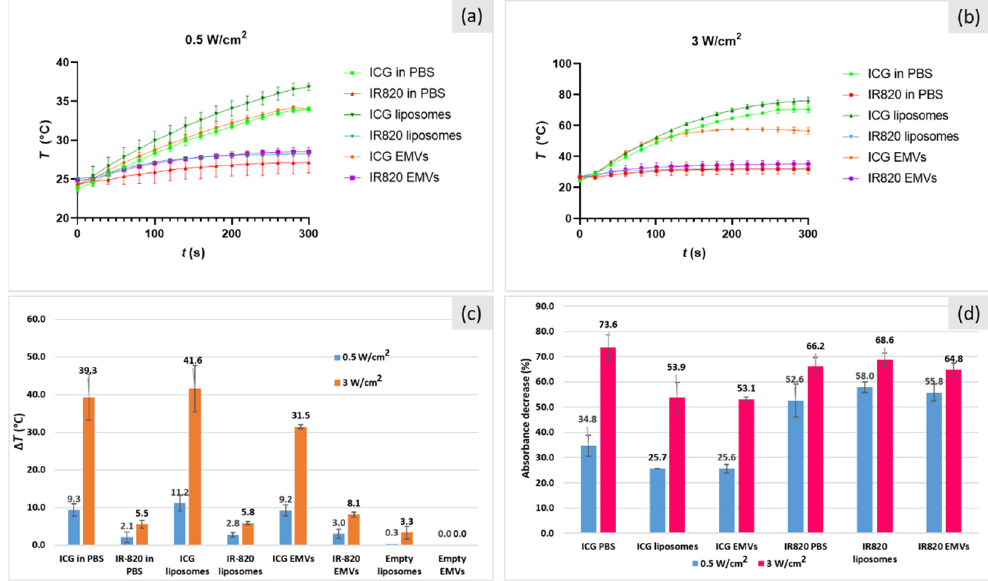
Figure 9. Photo-thermal experiments on dye-loaded nano-carriers. Heating profiles after 5 min irradiation with laser power ( a ) 0.5 and ( b ) 3 W/cm 2 . Data were reported as the mean ± SD. ( c ) Calculated temperature increase after 5 min laser irradiation. An increase in temperature ( Δ T ) was calculated by subtracting the initial temperature ( t = 0 s) from the maximum temperature reached. Three measurements were performed for each sample. ( d ) Absorbance decrease (%) as an indicator of dye decomposition was calculated from the absorbance peak values measured before and after irradiation. Three measurements were performed for each sample. Observed lower degradation for ICG-loaded carriers, at both laser powers, was proven to be statistically significant with Brown–Forsyth ANOVA ( p < 0,05). No statistically relevant differences were confirmed for IR820-loaded